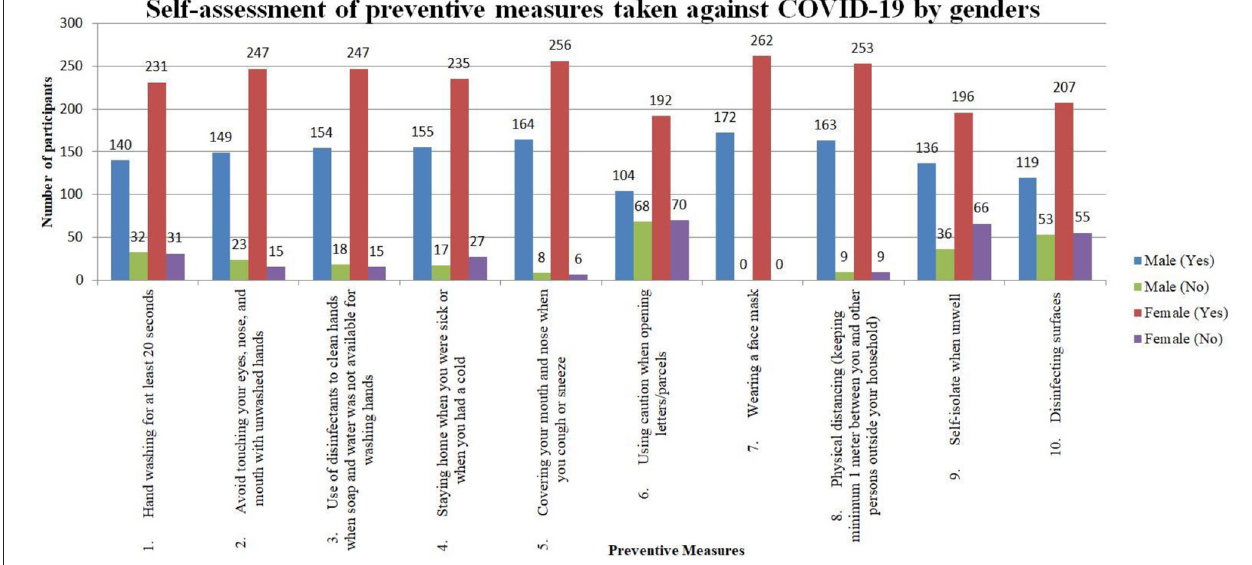
FIGURE 1 | Self-assessment of preventive measures taken against COVID-19 by genders.